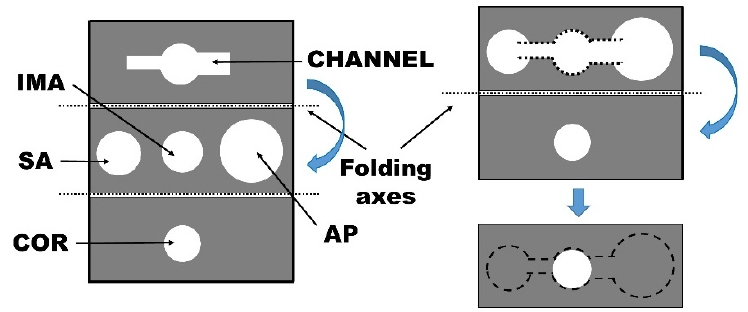
Figure 1. Scheme of the fluidic device including the folding axes ( left ) and folding procedure ( right